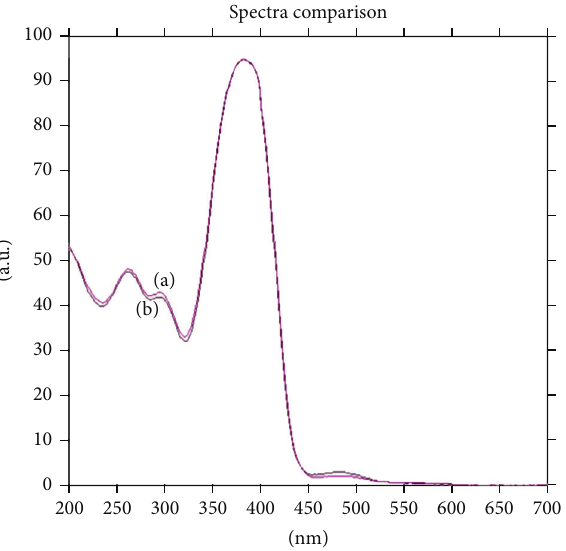
Figure 4: Peak-purity spectra of thiocolchicoside standard (a) and thiocolchicoside extracted from capsule (b) scanned at peak-start, peak-apex and peak-end